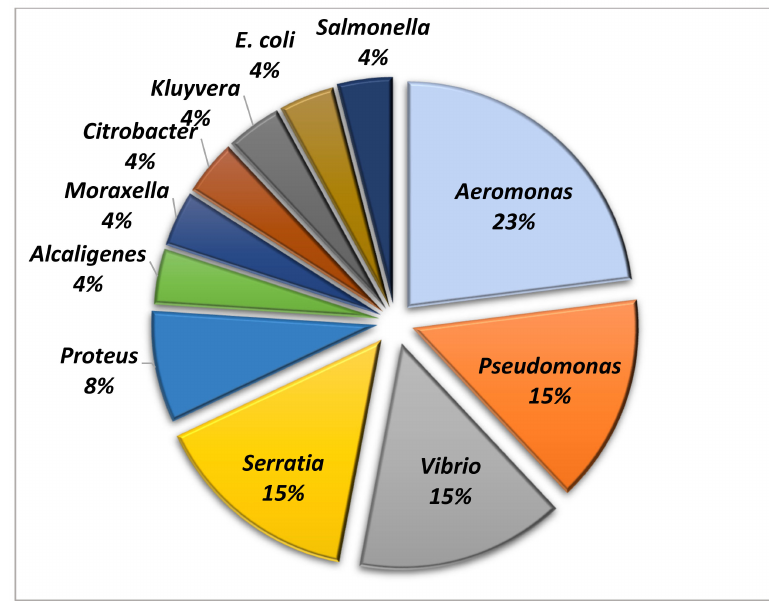
Figure 2. Genera found in oral/cloacal